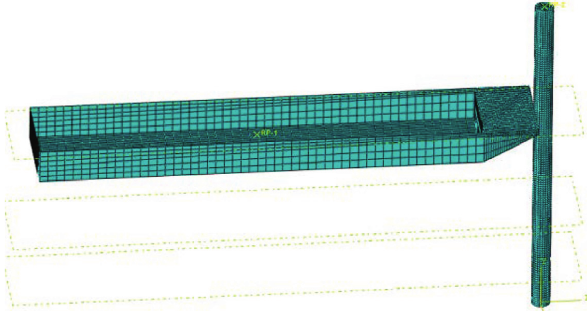
Figure 8: Finite element simulation of ship-bridge collision in